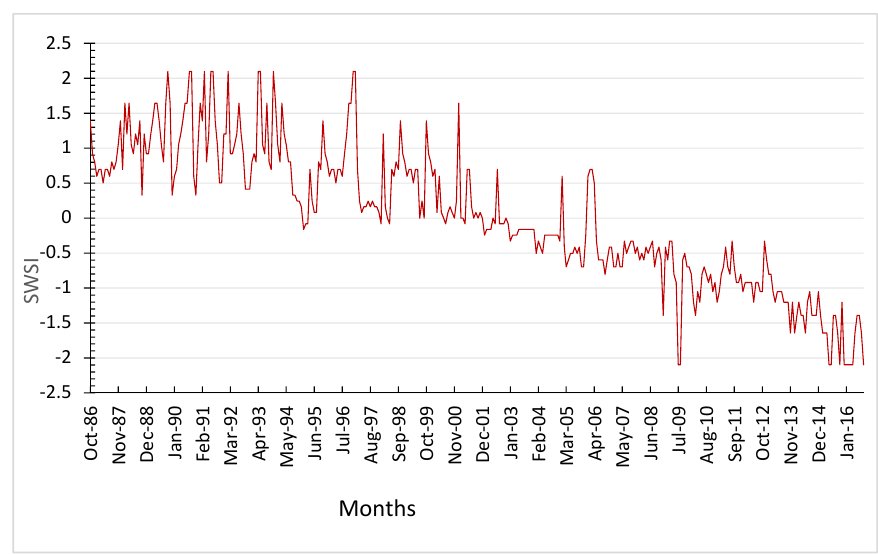
Figure 11. Standardized Water Storage Index (SWSI) values for station 1 for 30 years (360 months). Table 6. SWSI drought percentage from station 1.